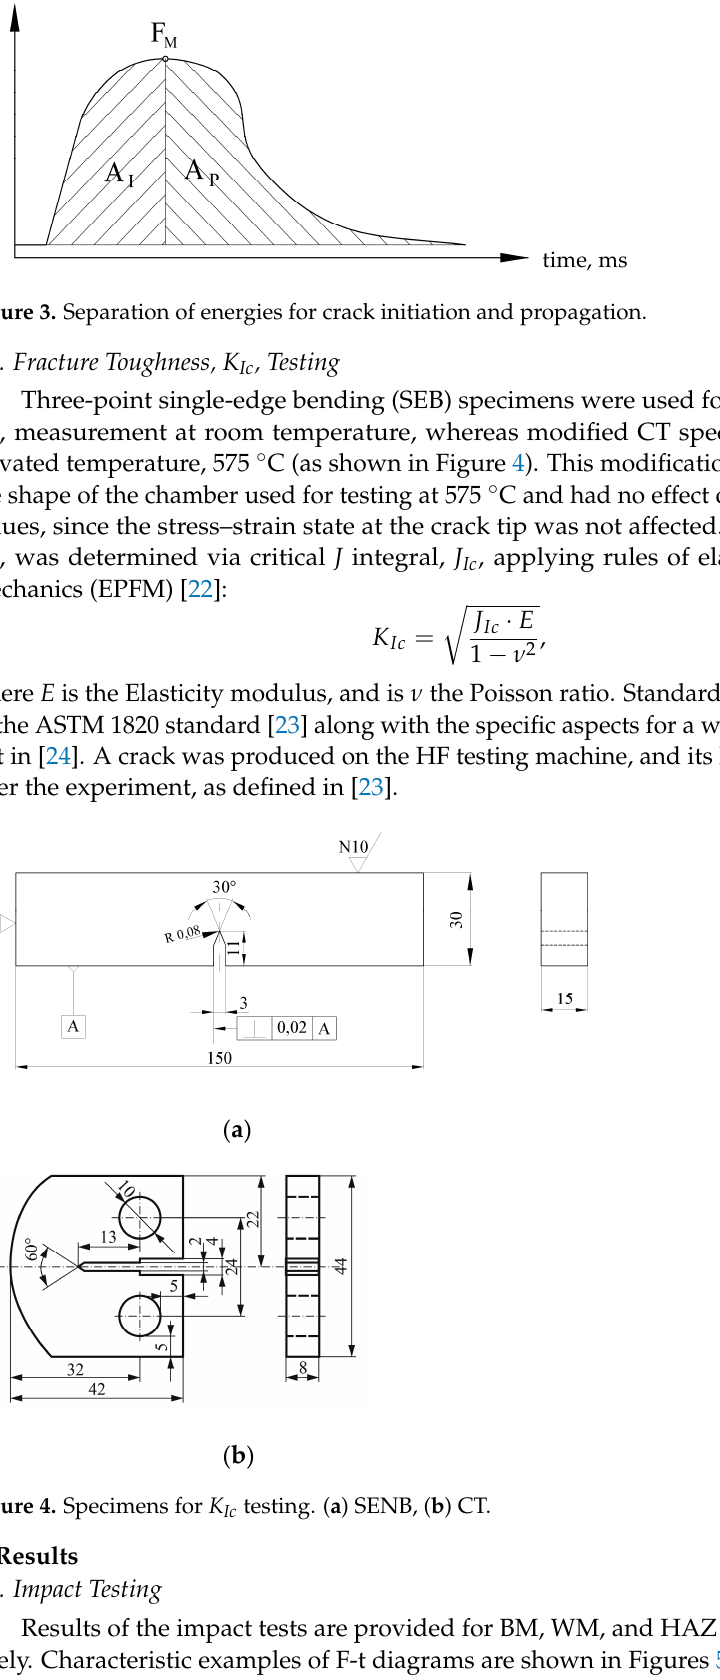
Figure 4. Specimens for K Ic testing. ( a ) SENB, ( b ) CT.